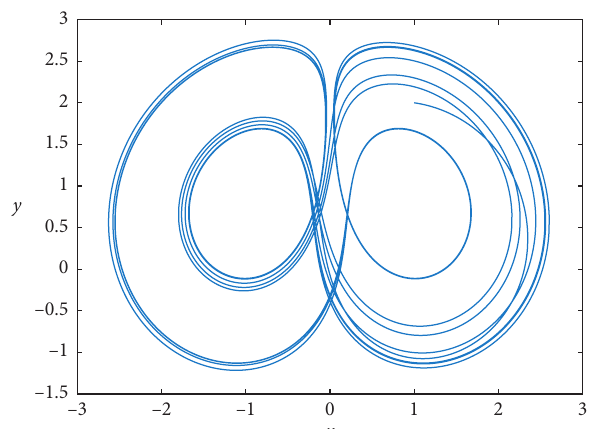
Figure 9: Dynamic behavior of fractional financial chaotic model with α � 0 .